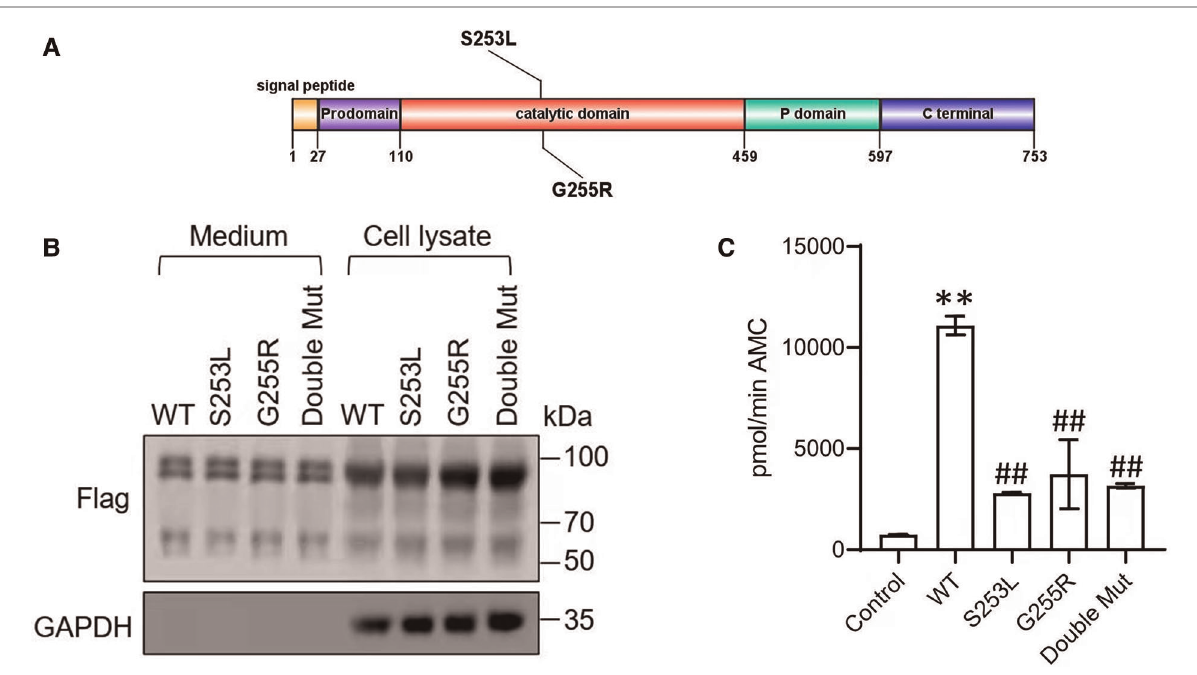
FIGURE 2 ( A ) Domain structure showing the novel S253L and G255L mutations within PC1/3. The PC1/3 exhibit an N-terminal signal peptide, followed by a prodomain, a catalytic-domain, a P-domain, and an enzyme-speci fi c C-terminal segment. ( B ) Western blot of PC1/3 wild-type and mutant protein expression. HEK293 cells were transfected with Flag-tagged wildtype PC1/3 (WT) or PC1/3s containing novel mutations. Medium and cell lysate were subjected to western blot using an anti-Flag antibody. GAPHD was used as a loading control. ( C ) Enzymatic activity of wild-type PC1/ 3 (WT) or PC1/3s containing novel mutations. The enzymatic activities of secreted PC1/3 proteins in conditioned medium were assayed using a fl uorogenic assay. ** p <0.01 vs. Control, ## p <0.01 vs. WT; n=6; error bar,